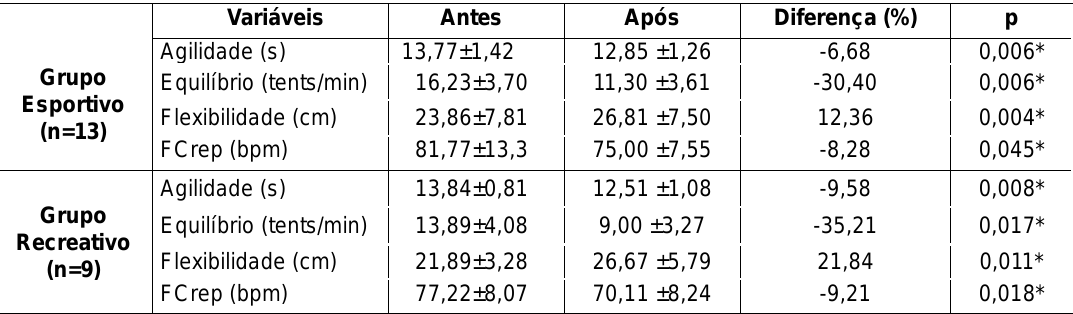
Tabela 4. Desempenho motor dos adolescentes no Grupo Esportivo e no Grupo Recreativo, antes e após os programas de exercício